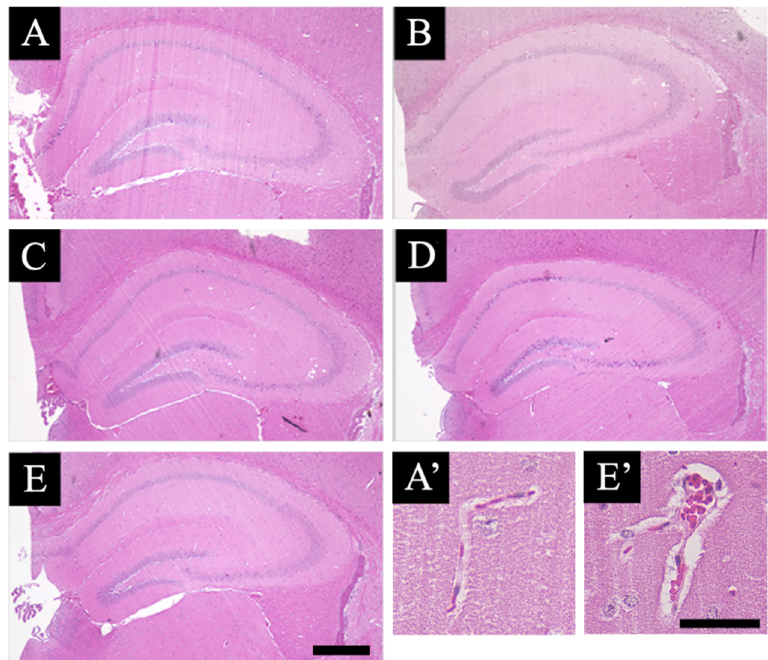
Figure 1. Hematoxylin and eosin (HE)-stained sections are shown: ( A – E ) indicate the HE-stained hippocampal sections of the vehicle-treated animals ( A ), piracetam-treated animals ( B ), aniracetam- treated animals ( C ), piracetam and α -GPC-treated animals ( D ), and aniracetam and α -GPC-treated animals ( E ). ( A’ , E’ ) indicate the blood vessels in the hippocampus of vehicle-treated animals ( A’ ) and aniracetam and α -GPC-treated animals ( E’ ). Scale bars in ( E , E’ ) = 500 µ m and 50 µ m,